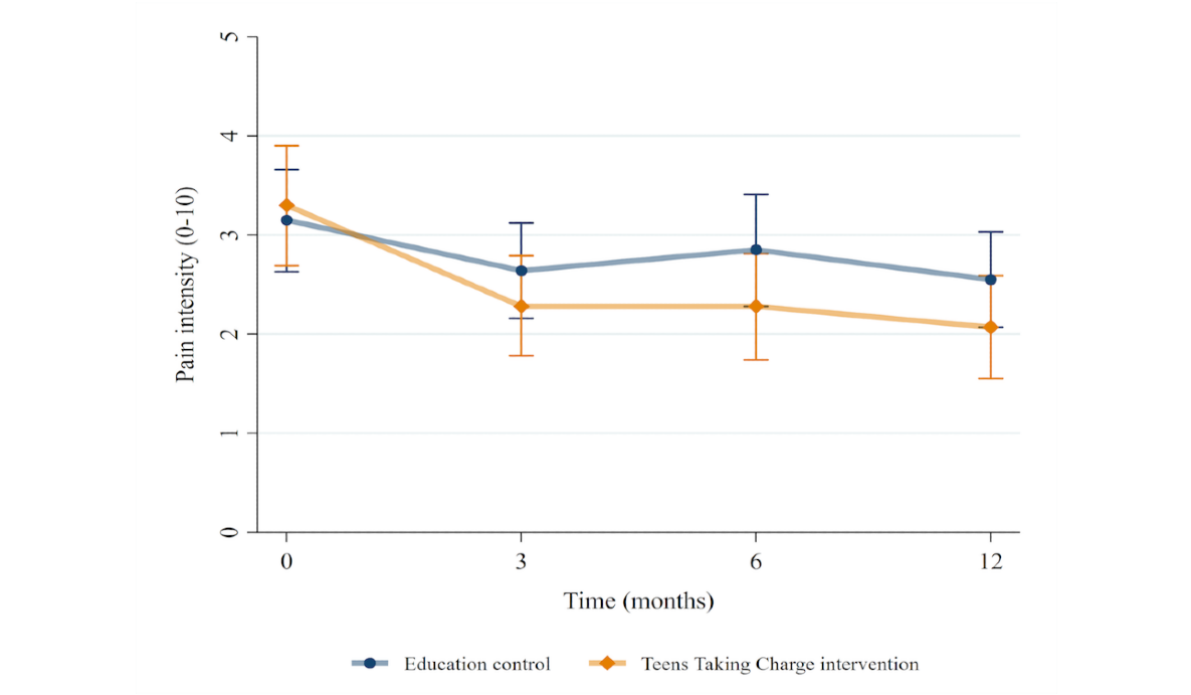
Figure 4. Pain intensity scores over time in each treatment group, mean and 95%